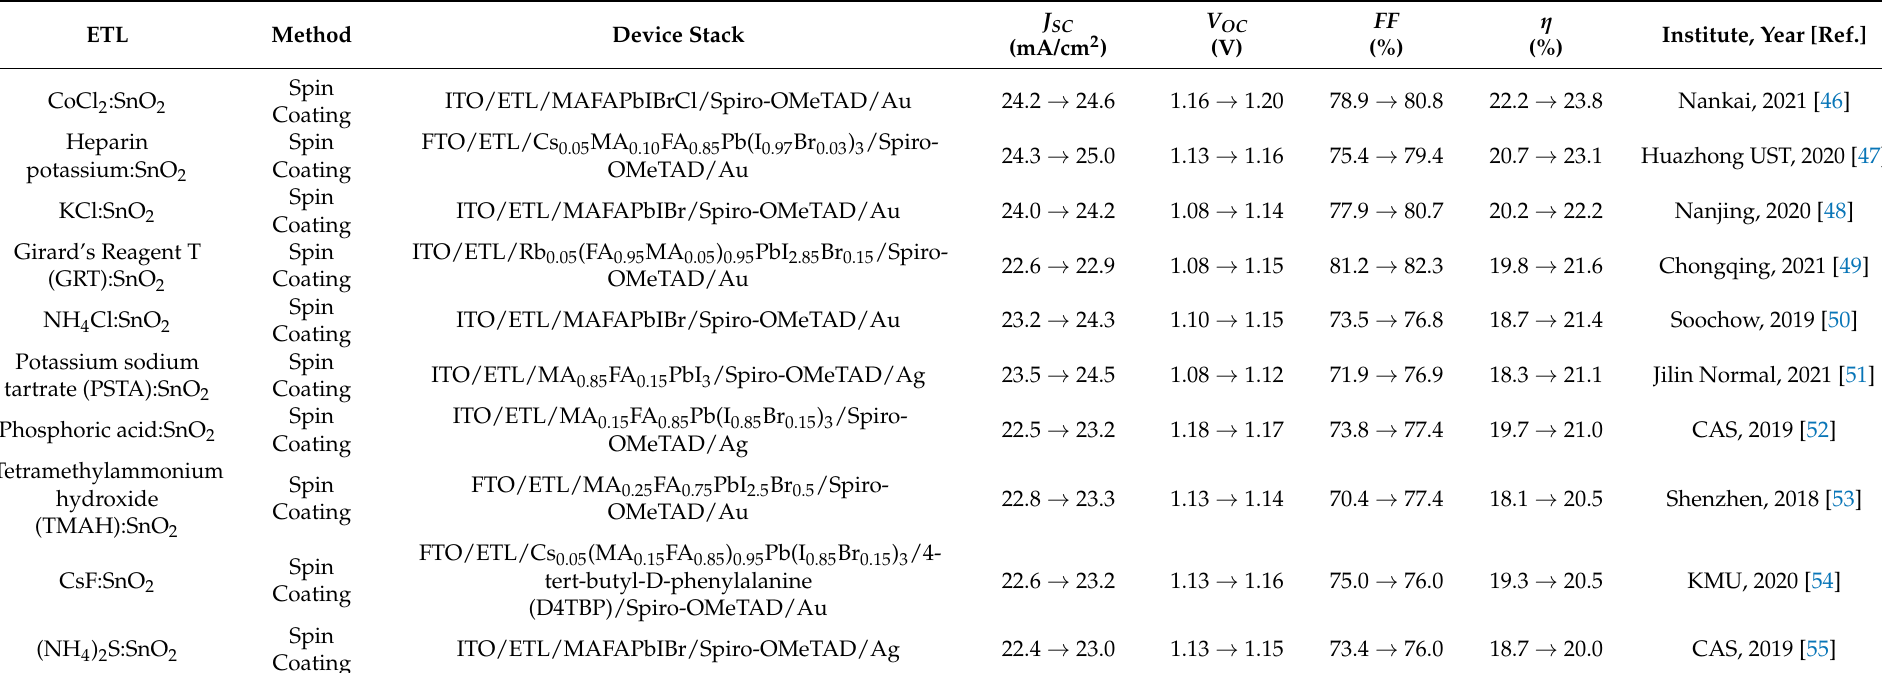
Table 4. Summary of perovskite-solar cells based on bulk incorporation of ionic compounds into SnO 2